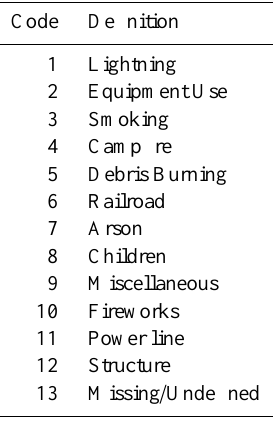
Table 4. Owner codes and definitions.